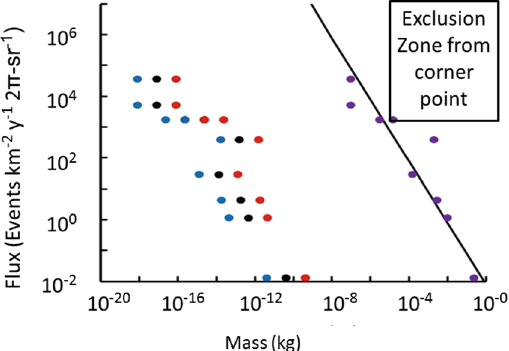
Figure 3. The flux versus quark nugget mass from Porter, et al . 30 and the magnetopause model. The results from Porter, et al . are shown in purple and are based on the geometric cross section. The masses from analysis with the magnetopause cross section are shown for Tatsumi’s surface magnetic field B o = 10 12 + / − 1 T in black for 10 12 T, blue for 10 11 T, and red for 10 13 T. The width of the pattern of three ellipses indicates the dominant uncertainty in the inferred mass. The black line is the expected flux if all the dark matter had a single mass. The exclusion zone for one point shows the region in flux-mass space that the lack of observed events would exclude if and only if all of dark matter had that